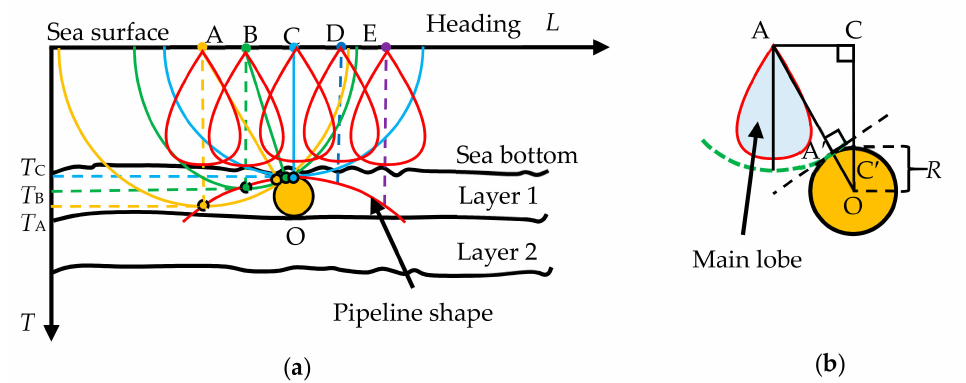
Figure 2. Pipeline imaging mechanism. ( a ) Pipeline shape formation process; ( b ) geometric relationship between the pipeline and the transducer when the transmitted acoustic signal reaches the